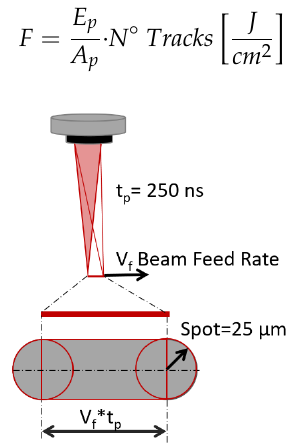
Figure 2. Irradiated surface area in each pulse.